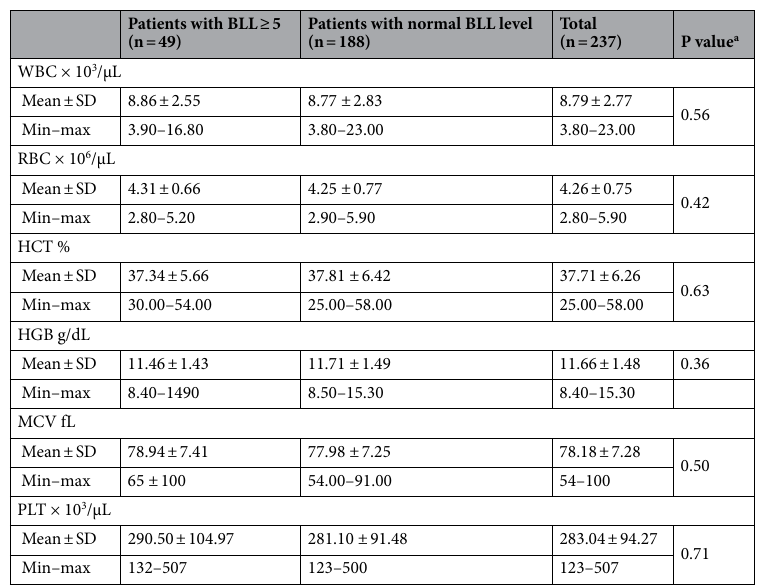
Table 2. Complete blood count (CBC) results of the patients. a Mann–Whitney U-test.